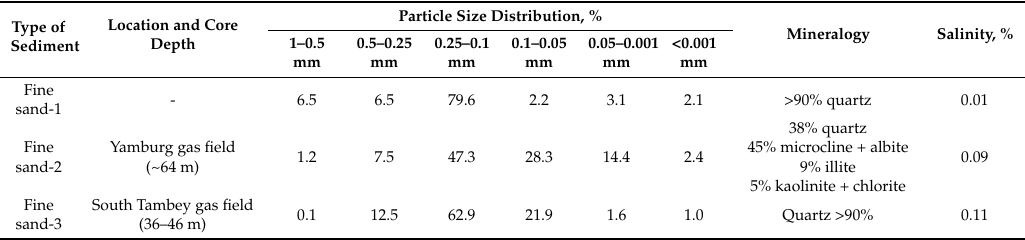
Table 1. Particle size distribution, mineralogy, and salinity of